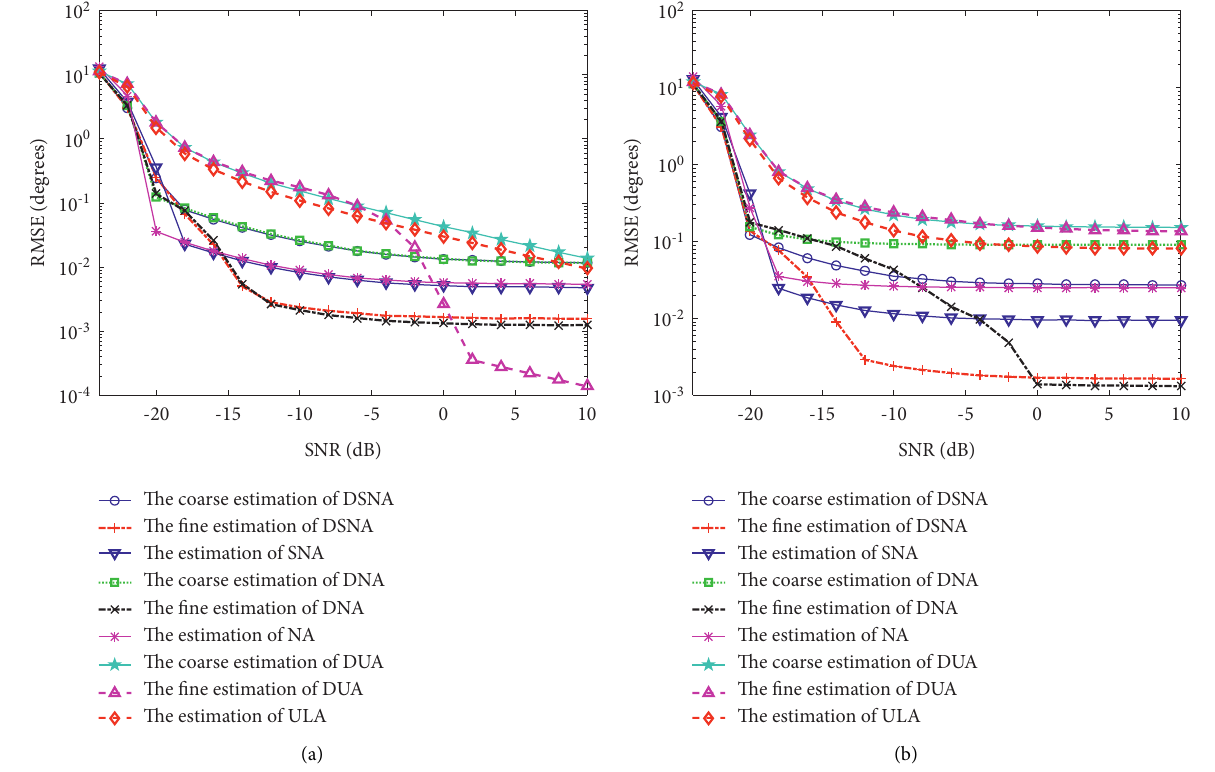
Figure 11: Multiple-source signals and d � λ /2; the baseline length is 250 times the wavelength. (a) Not considering mutual coupling between the array antennas. (b) Considering mutual coupling between the array